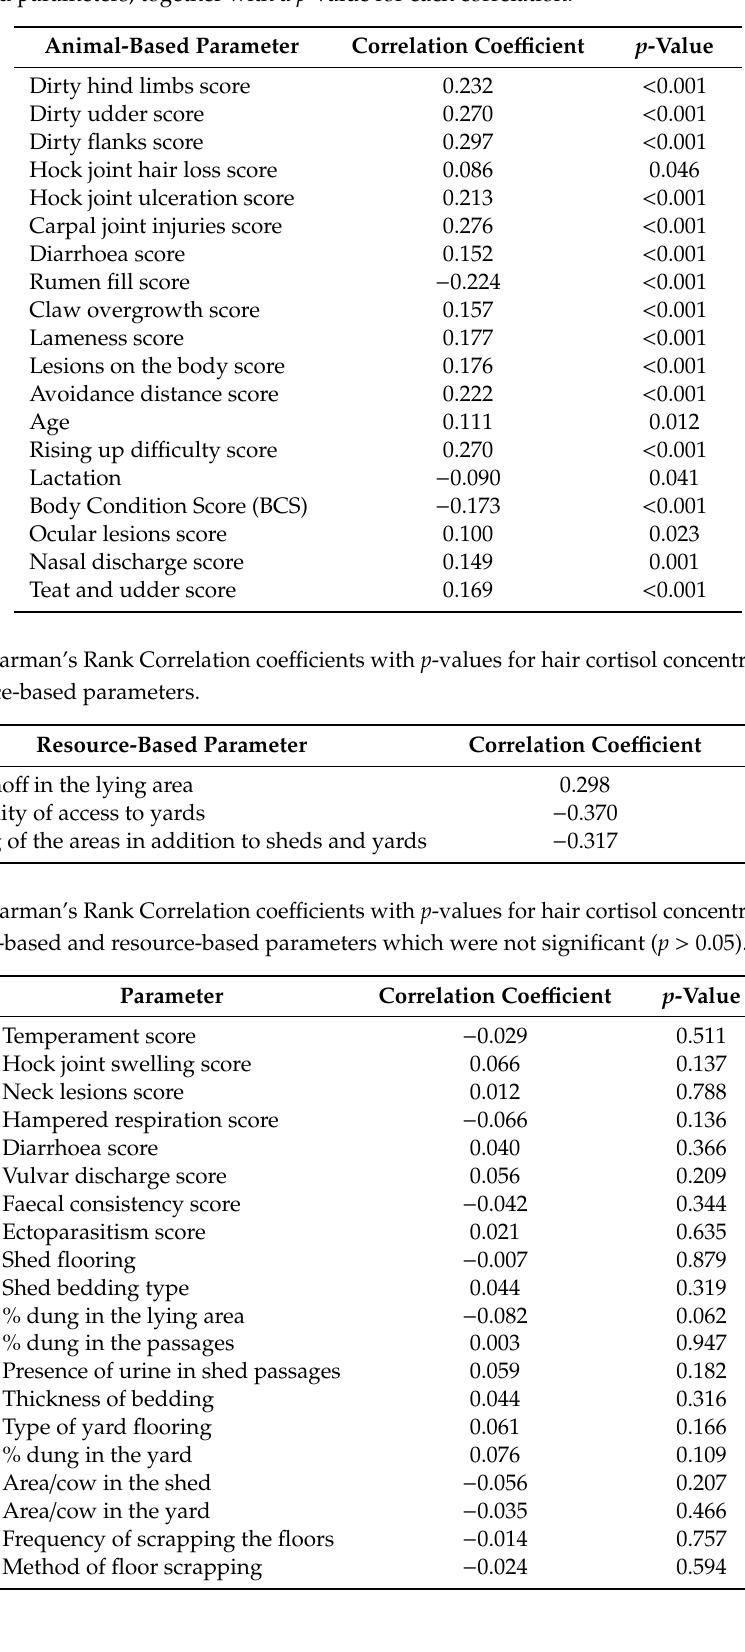
Table 3. Spearman’s Rank Correlation coe ffi cients for hair cortisol concentration (pg / mg) with other animal-based parameters, together with a p -value for each correlation.